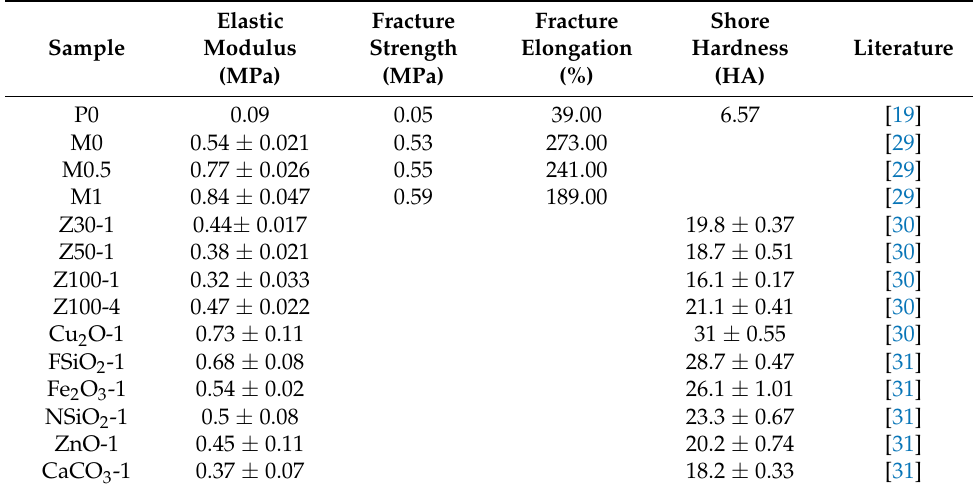
Table 4. Mechanical properties of PDMS coatings reinforced by different particles in